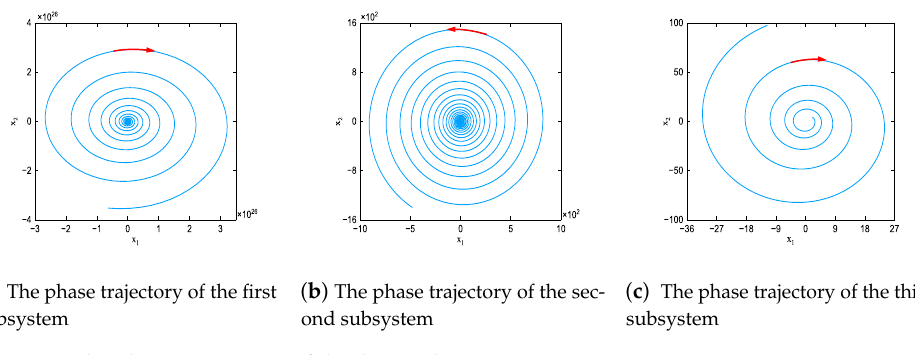
Figure 8. The phase trajectories of the three